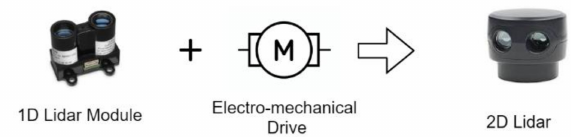
Figure 17. Conceptual design of 2D LiDAR based on 1D LiDAR module and electromechanical scanning stage.